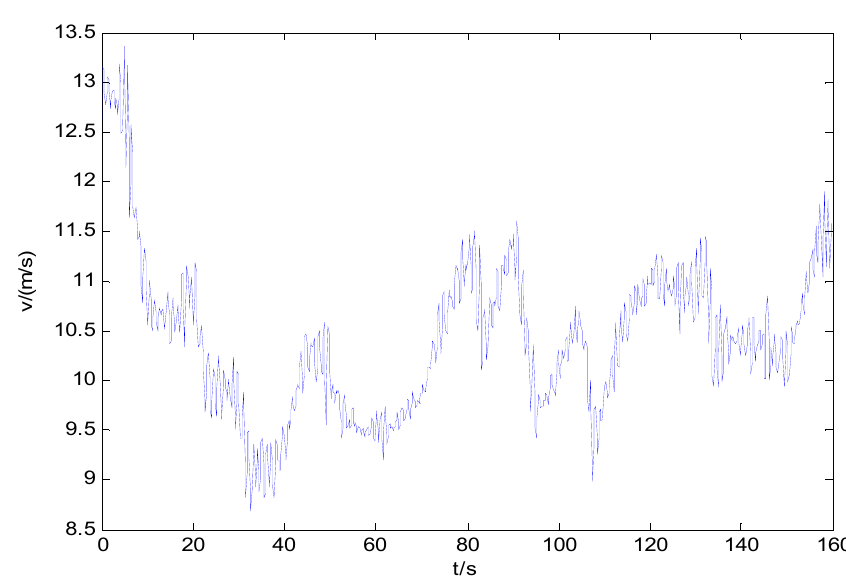
Figure 9. Vehicle speed history.